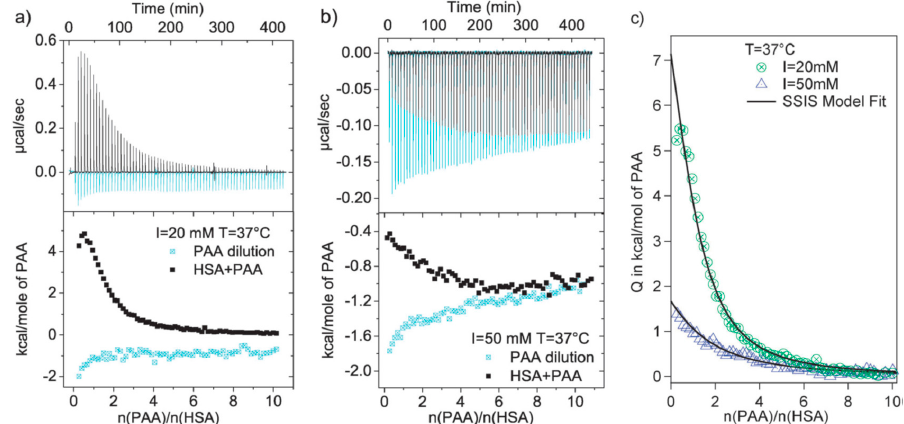
Figure 5. ( a ) ITC data of adsorption of poly(acrylic acid) (PAA) upon HSA and the corresponding heats of dilution of PAA at pH = 7.2, T = 37.1 °C, and ( a ) I = 20 mM and ( b ) I = 50 mM. ( c ) Binding isotherm corrected for the heat of dilution at 37.1 °C, and I = 20 mM and 50 mM. Figure 5 was taken from the work of [59].